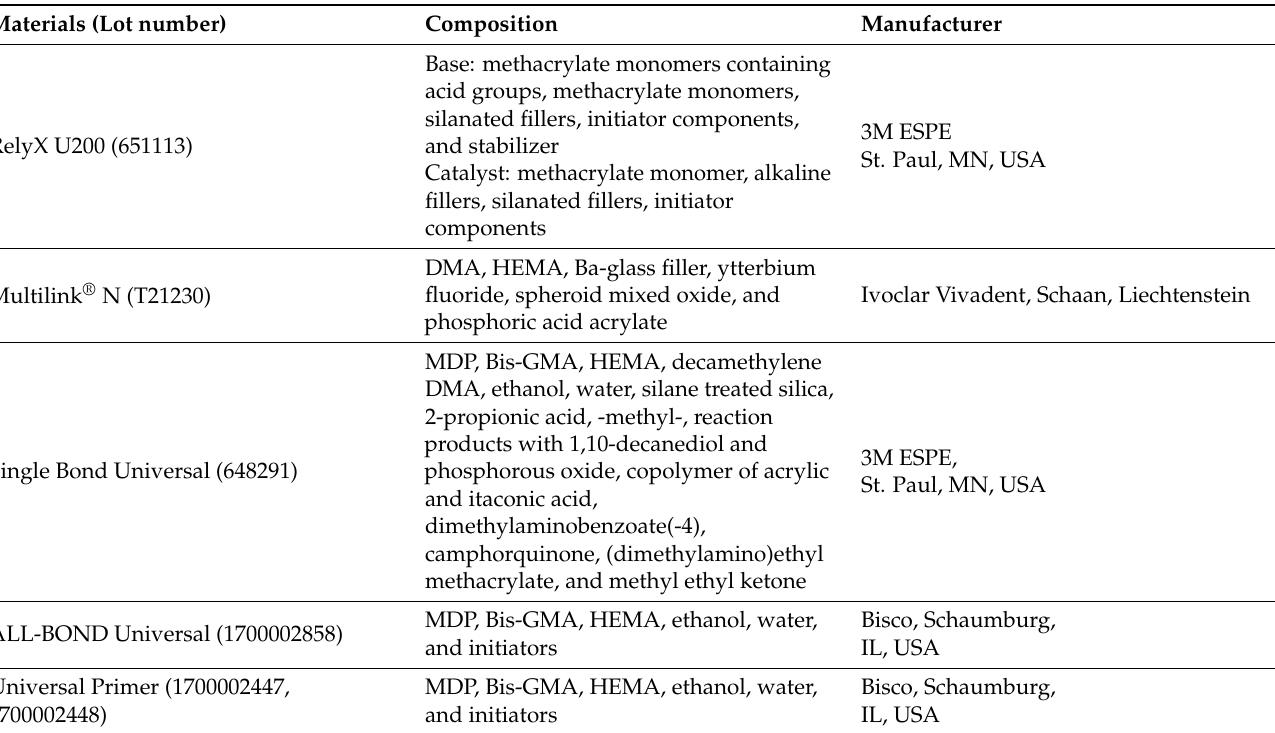
Table 1. Composition of the materials